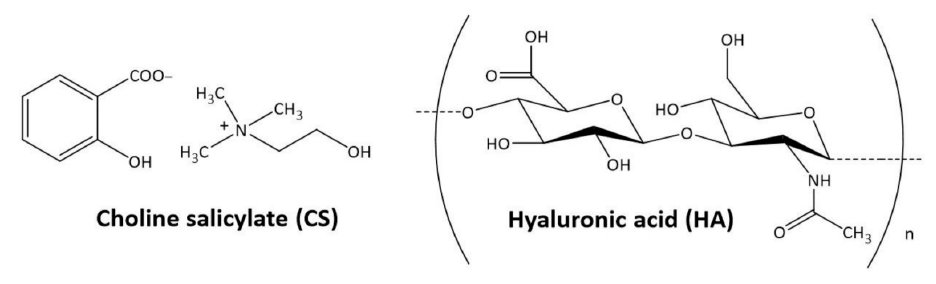
Figure 1. Structural formulas of choline salicylate (CS) and hyaluronic acid